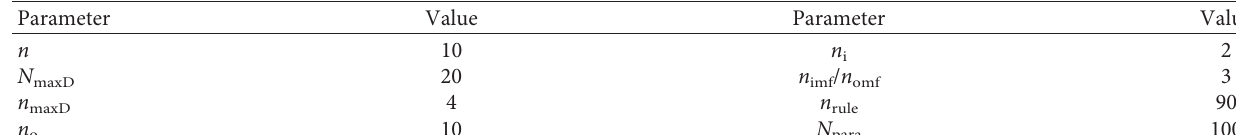
Table 4: Parameter conditions for the encoding strategy.